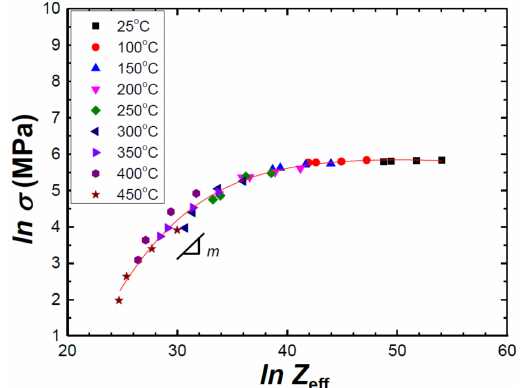
Figure 4. A plot of ln σ vs. ln Z eff for the 5182 alloy for a temperature range between 25 and 450 ◦ C at a given strain of